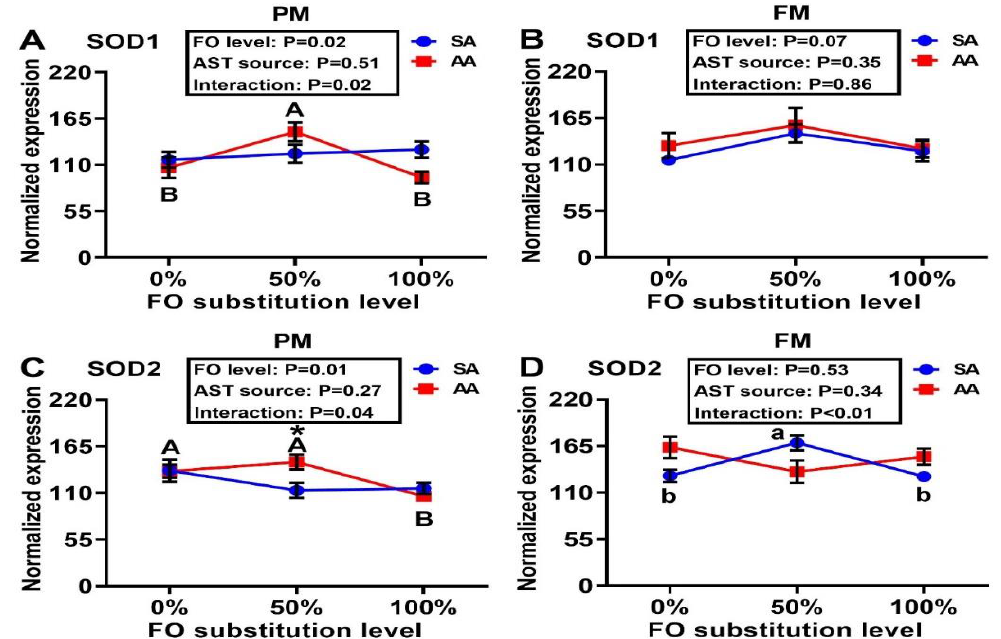
Figure 5. Effects of dietary fish oil substitution by DHA-rich microalgae and source of astaxanthin on hepatic mRNA levels of SOD1 ( A , B ) and SOD2 ( C , D ) of juvenile rainbow trout fed the plant meal- (PM, A , C ) and fishmeal (FM, B , D )-based diets. Means labelled with different letters [lowercase (a, b), synthetic astaxanthin (SA) groups; uppercase (A, B), microalgae astaxanthin (AA) groups] are different between various fish oil substitutions ( p < 0.05). Asterisks ( * ) indicate differences between SA and AA groups ( p < 0.05) at the same level of FO substitution. The absence of different letters (a, b or A, B) or asterisks ( * ) between means indicates no significant differences. SOD: superoxide dismutase. FO: fish oil. AST: astaxanthin.